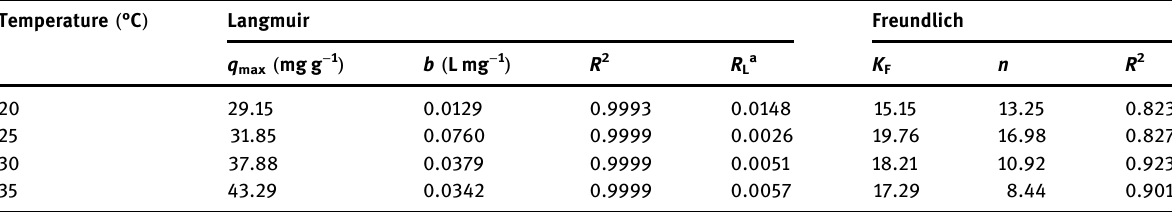
Table 2: Adsorption isotherm constants for GPC adsorption on resin 001 × 7 Temperature ( °C ) Langmuir